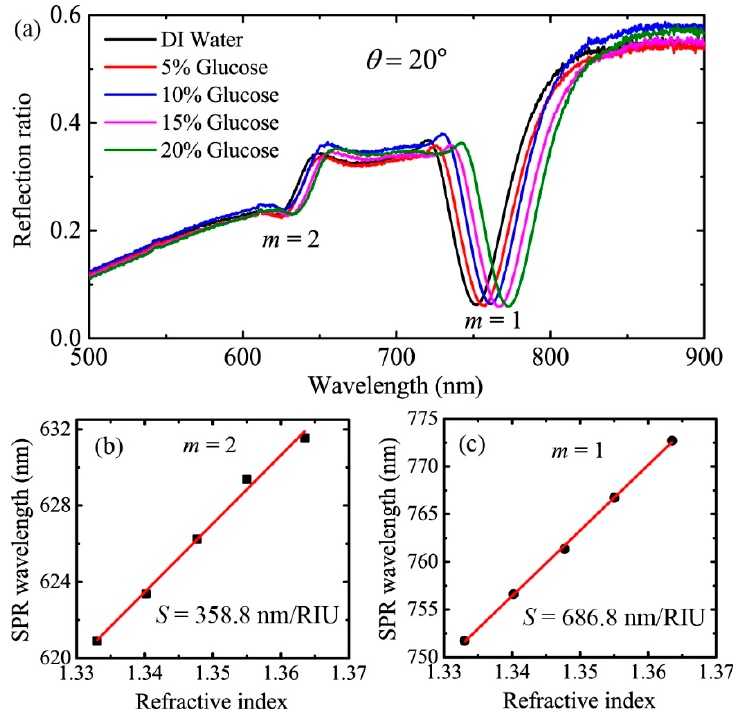
Figure 5. ( a ) The reflection spectra of the analytes experimentally measured at the incident angle of 20 degrees, ( b ) and ( c ) are the SPR wavelength as a function of the refractive index for diffraction orders of m = 2 and m = 1, respectively. The red lines are linear fits of the experimental data.